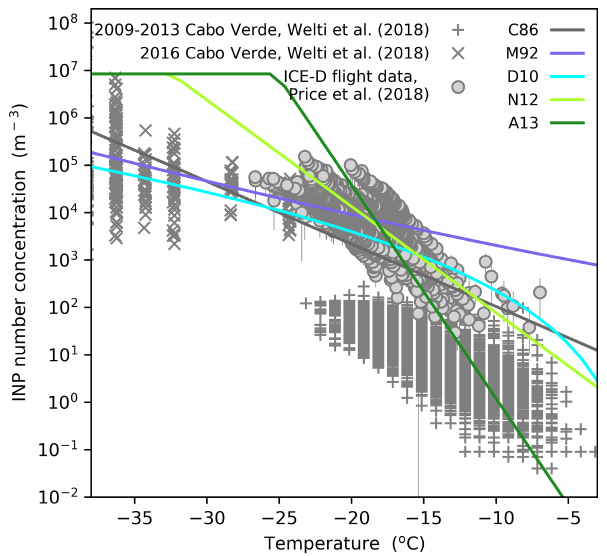
Figure 2. Dependence of the INP number concentration on tem- perature (d[INP] / d T ) for the five heterogeneous freezing parame- terisations simulated in this study (C86, M92, D10, N12 and A13) compared to INP number concentrations measured in the eastern tropical Atlantic (Price et al., 2018; Welti et al., 2018). Parameter- isations are shown for the aerosol concentrations at approximately the first freezing level in our simulations ( ∼ 8cm − 3 ). D10, N12 and A13 are dependent on the aerosol concentrations, whereas C86 and M92 are not dependent on the aerosol concentration. N12 and A13 are calculated assuming a mean dust particle radius of 0.7µm. In D10, all particles are assumed to be larger than 0.5µm. Note that the Welti et al. (2018) dataset is from surface INP measurements at Cabo Verde, whereas the Price et al. (2018) dataset is measured from an aircraft flown from Cabo